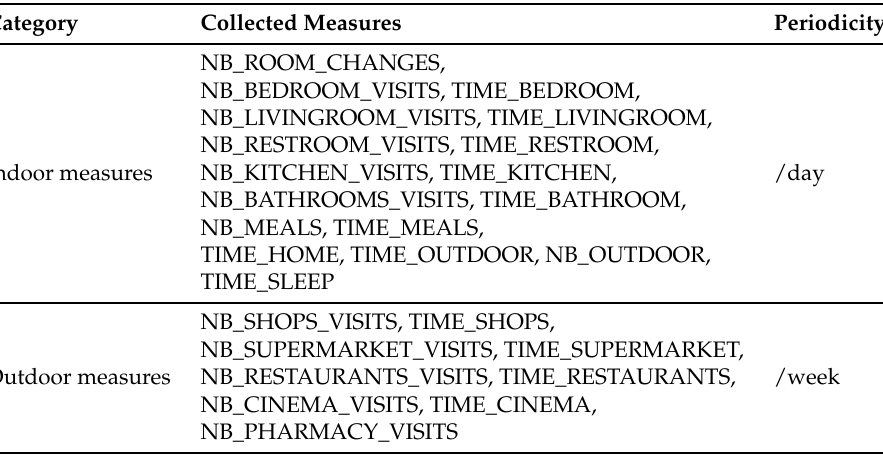
Table 6. Montpellier pilot site measures.